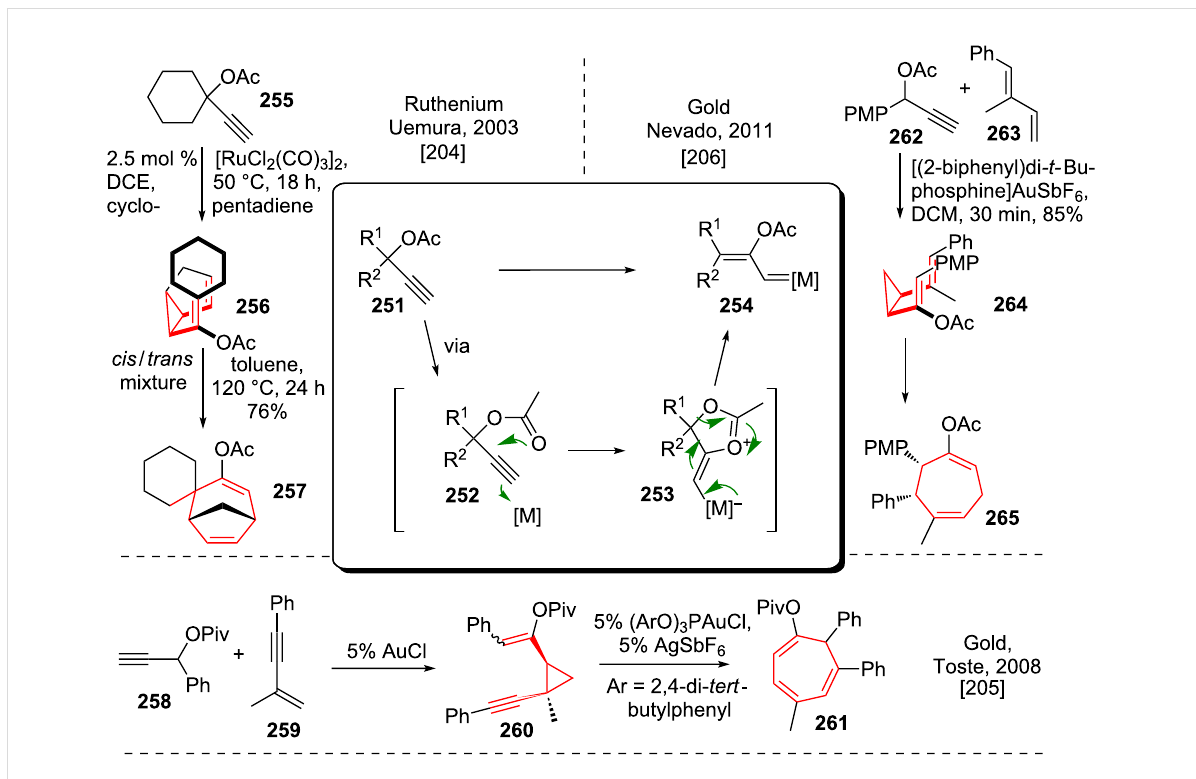
Scheme 33: Ruthenium- and gold-catalyzed versions of tandem reactions involving a DVCPR.